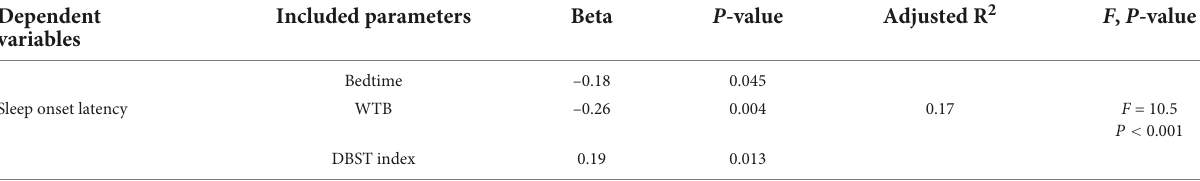
TABLE 4 Stepwise linear regression analysis to explore the predictive variables of sleep onset latency in patients with cancer ( n =